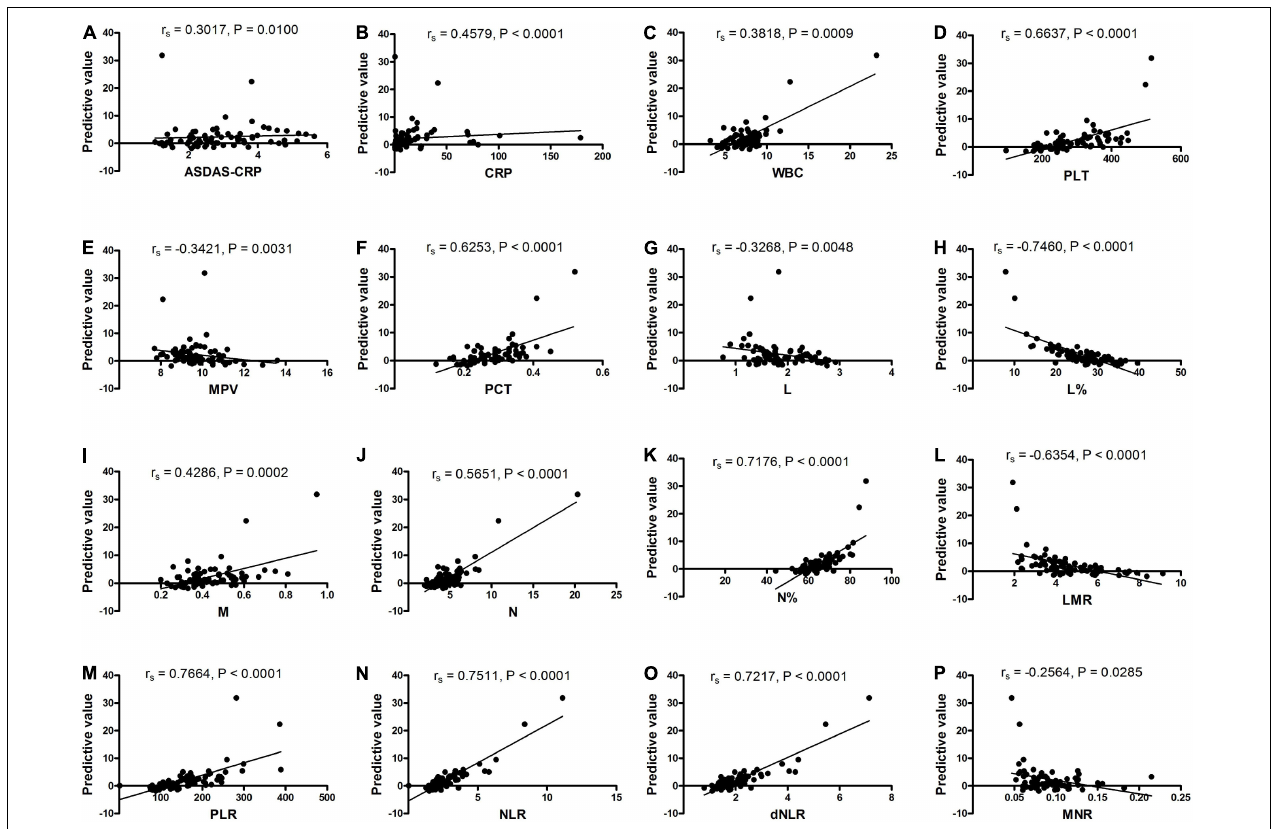
FIGURE 5 | The predictive model correlated with the activity and severity of AS. (A) The predictive model correlated with ASDAS-CRP. (B) The predictive model correlated with CRP. (C) The predictive model correlated with WBC. (D) The predictive model correlated with PLT. (E) The predictive model correlated with MPV. (F) The predictive model correlated with PCT. (G) The predictive model correlated with L. (H) The predictive model correlated with L%. (I) The predictive model correlated with M. (J) The predictive model correlated with N. (K) The predictive model correlated with N%. (L) The predictive model correlated with LMR. (M) The predictive model correlated with PLR. (N) The predictive model correlated with NLR. (O) The predictive model correlated with dNLR. (P) The predictive model correlated with MNR. AS, ankylosing spondylitis; ASDAS, AS Disease Activity Score; CRP, C reaction protein; dNLR, derived neutrophil-lymphocyte; L, lymphocyte counts; L%, lymphocyte percentages; LMR, lymphocyte-to-monocyte; M, monocyte counts; MNR, monocyte-to-neutrophil; MPV, mean platelet volume; N, neutrophils counts; N%, neutrophil percentages; NLR, neutrophil-to-lymphocyte; PCT, plateletcrit; PLR, platelet-to-lymphocyte; PLT, platelet count; WBC, white blood cell